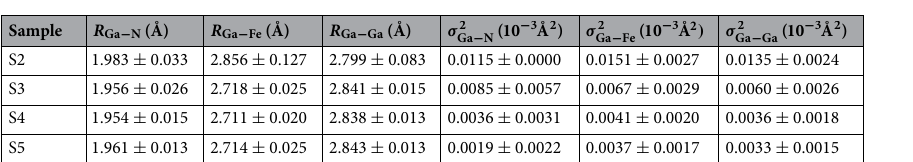
Table 2. Structural parameters extracted from the quantitative DAFS analysis. R -range of the fits = [0.6– 4.3] Å.